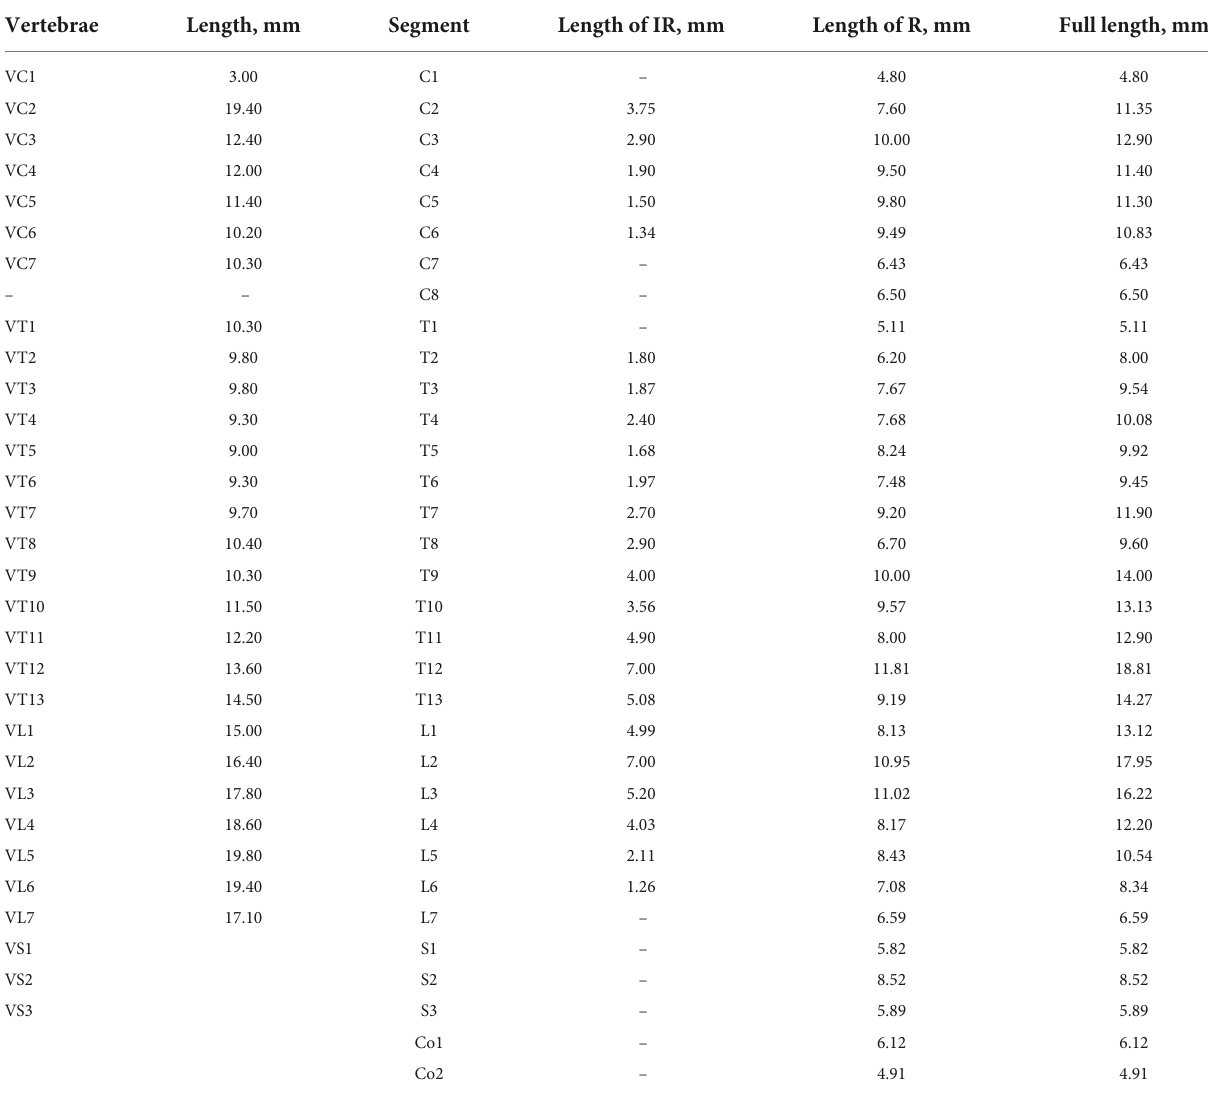
TABLE 2 Lengths of the spinal segments and